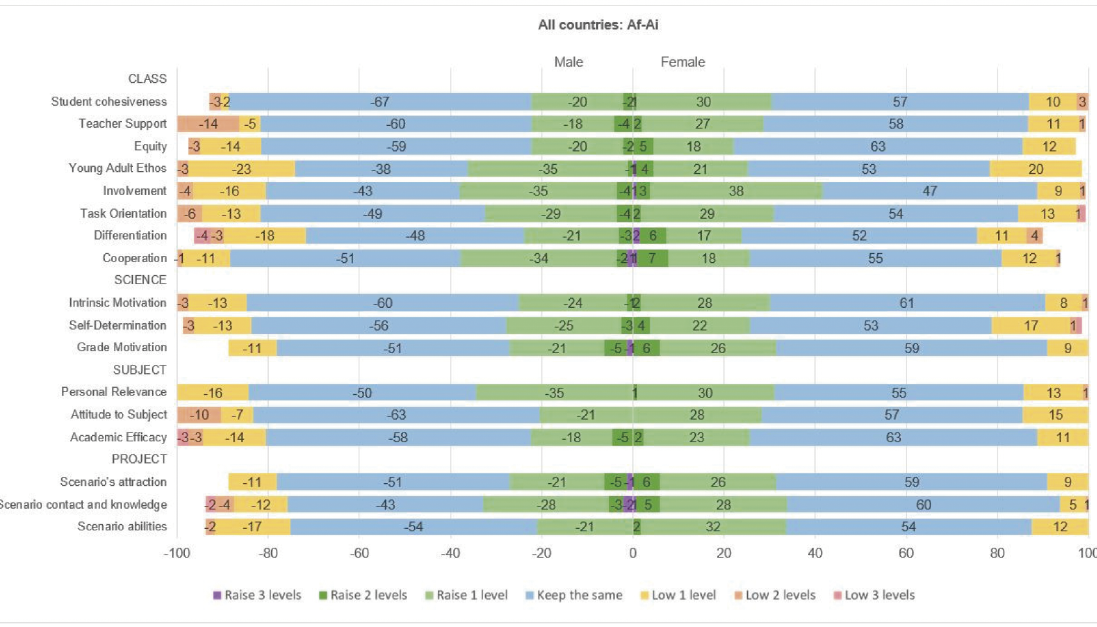
Figure 5. Differences between the reality at the end of the implementation of the project in the classroom (Af) and the initial situation (Ai) of all participating students